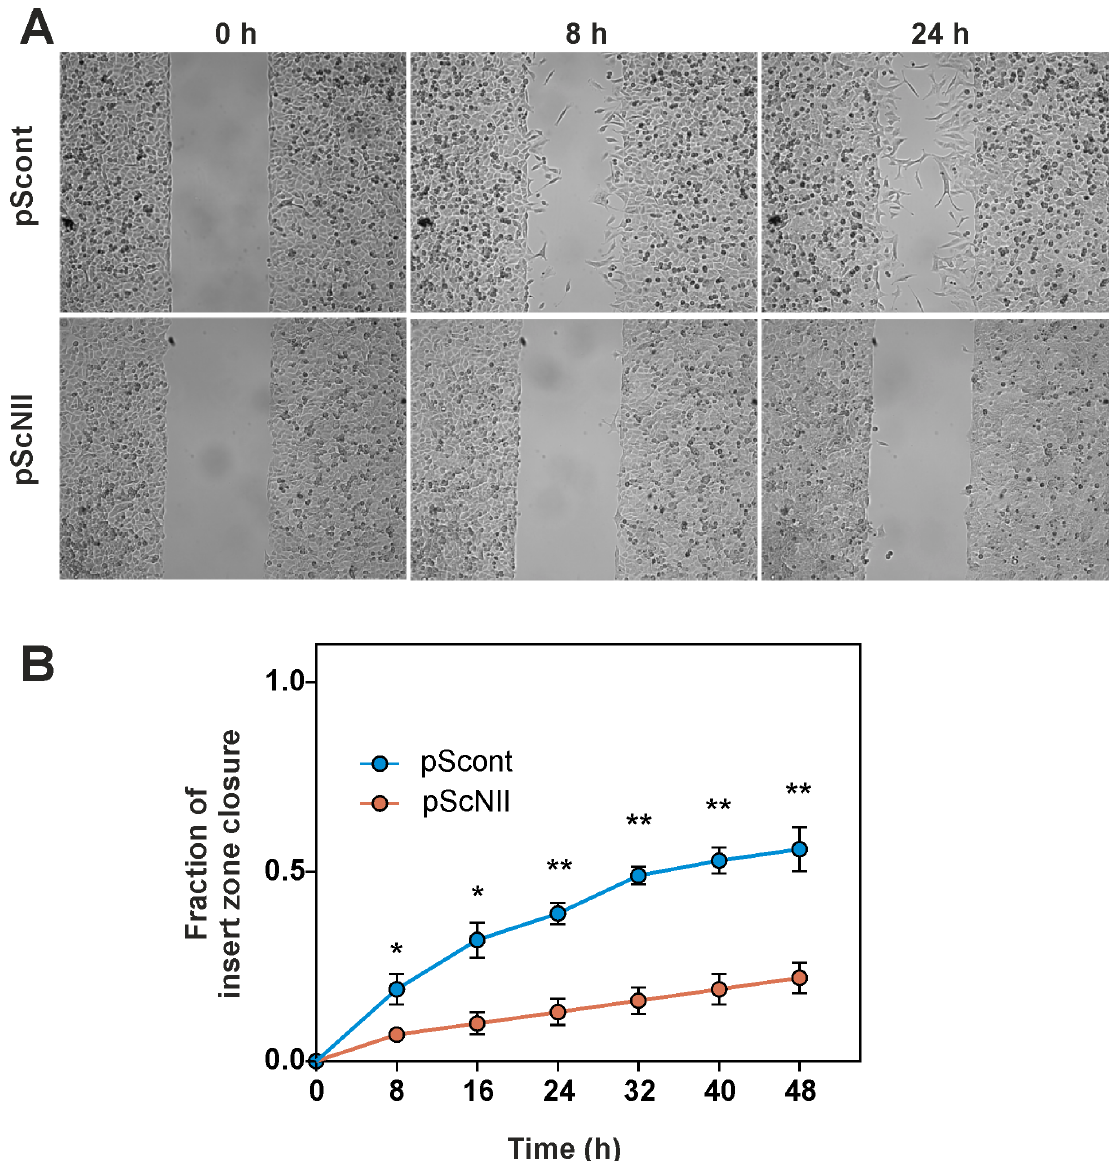
Figure 7. Wound healing assay in A549 cells. The assay was performed as described in Materials and Methods in a medium containing 0.25% FBS with a JuLI Br Live Cell Movie Analyser. ( A ) Representative images captured at 0, 8, 20 h during assay performed on pScont and pScNII cells (wound width is 500 µm); ( B ) percentage of the insert zone closure in the wound edge as function of time. The results are the mean + SEM of three independent experiments. * p < 0.05, ** p < 0.01.